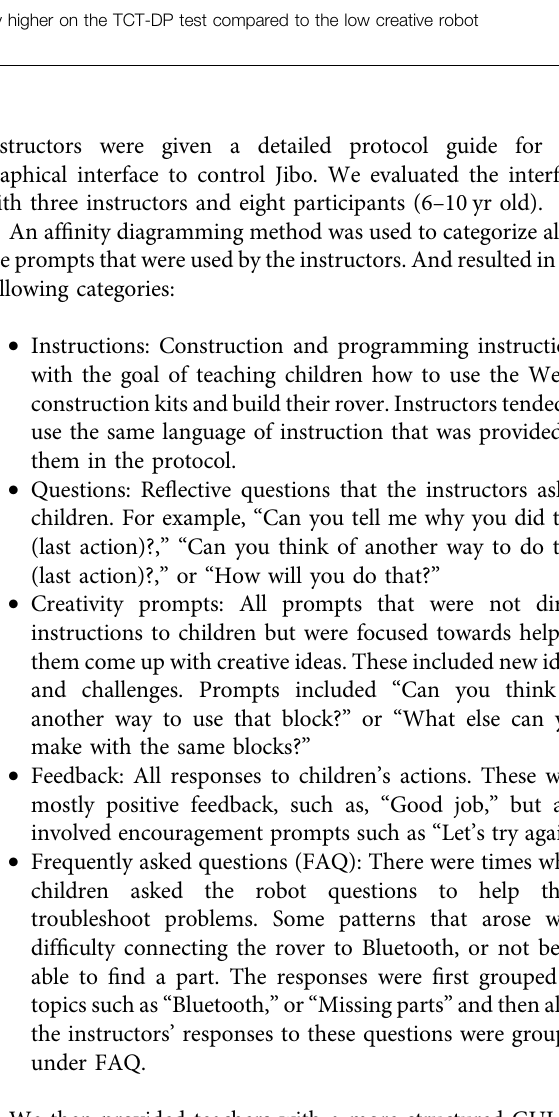
Frontiers in Robotics and AI |